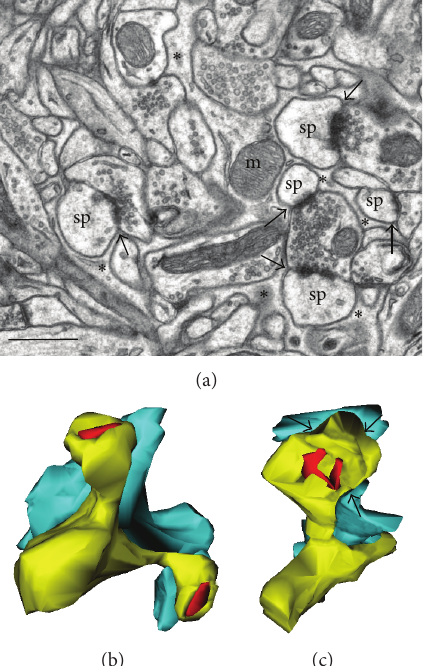
Figure 1: Electron microscopy images and 3D reconstructions illustrating glial coverage of excitatory spine synapses in neocortex. (a) EM micrograph of the neuropil in the adult mouse cortex with dendritic spine synapses (sp) surrounded by astrocytic processes marked with asterisks. Note mitochondria (m) in the branching point of astrocytic processes and perisynaptic astrocytic processes (PAPs) contacting axon-spine interface (ASI, arrows). (b) 3D recon- struction of the PAP near spine synapses with simple PSDs in adult rat hippocampus. Dendritic segment with two spines is in yellow, PSDs are in red, and PAP is in blue. (c) The same but for the big spine with complex PSD. Arrows point at ASI covered by the PAP. Note that in both reconstructions a large fraction of ASI is devoid of PAPs (original data). Scale bar: 1 𝜇